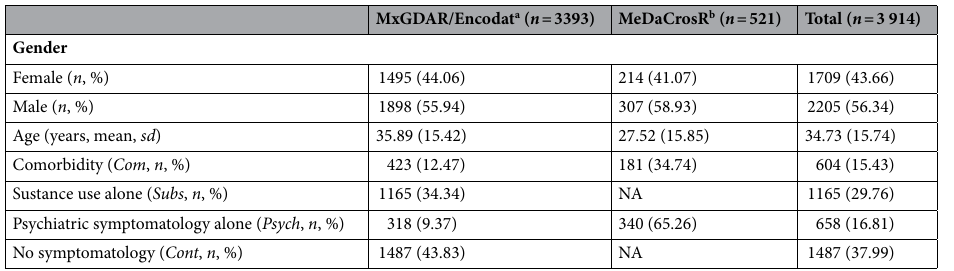
Table 1. Overview of the Sociodemographic and Clinical Characteristics of the Samples. a MxGDAR Mexican Genomic Database for Addiction Research. b MeDaCrosR Mexican Genomic Database for Cross Disorder